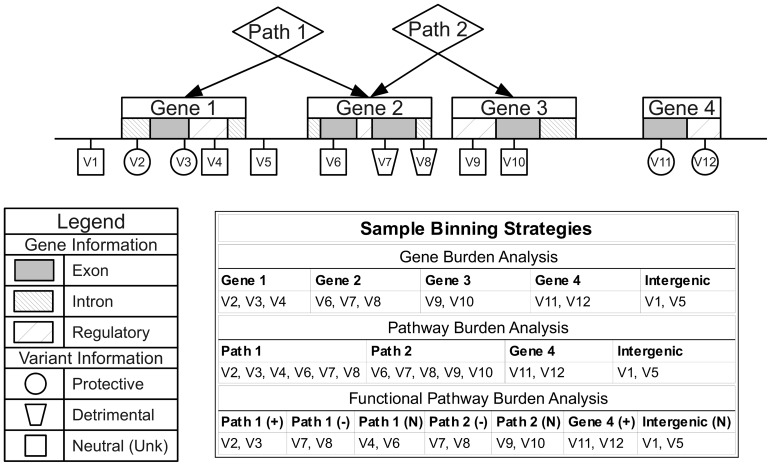
Alternate binning strategies using biological knowledge and functional or role annotations.Three example binning strategies: gene burden analysis, pathway burden analysis, and functional pathway burden analysis using four genes, two pathways, and variant functional prediction information.